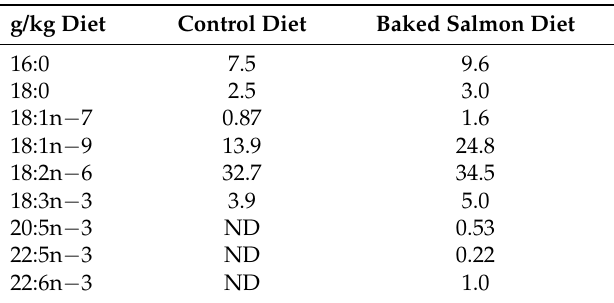
Table 2. Fatty acid contents in the experimental diets 1